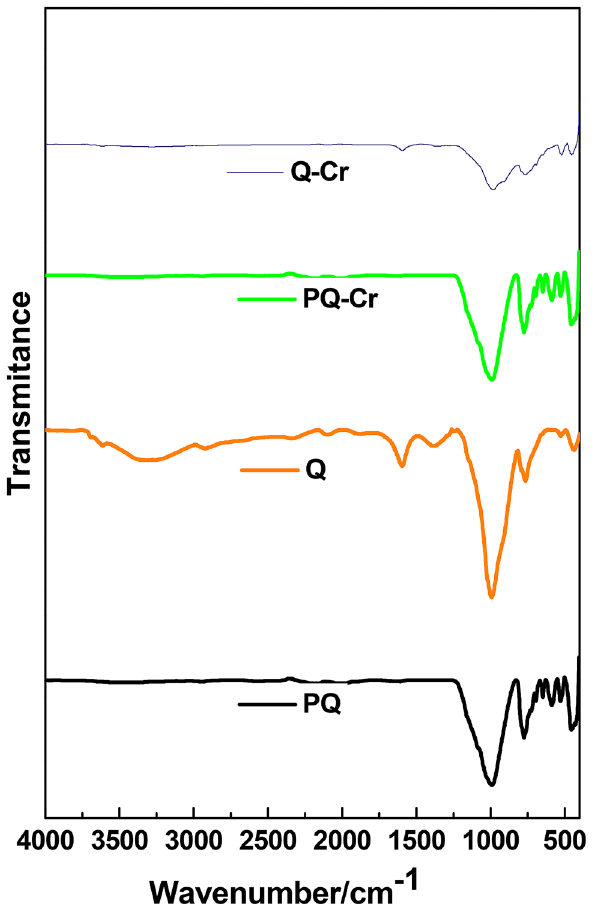
Figure 3. FTIR spectra of PQ, Q, PQ-Cr and Q-Cr.